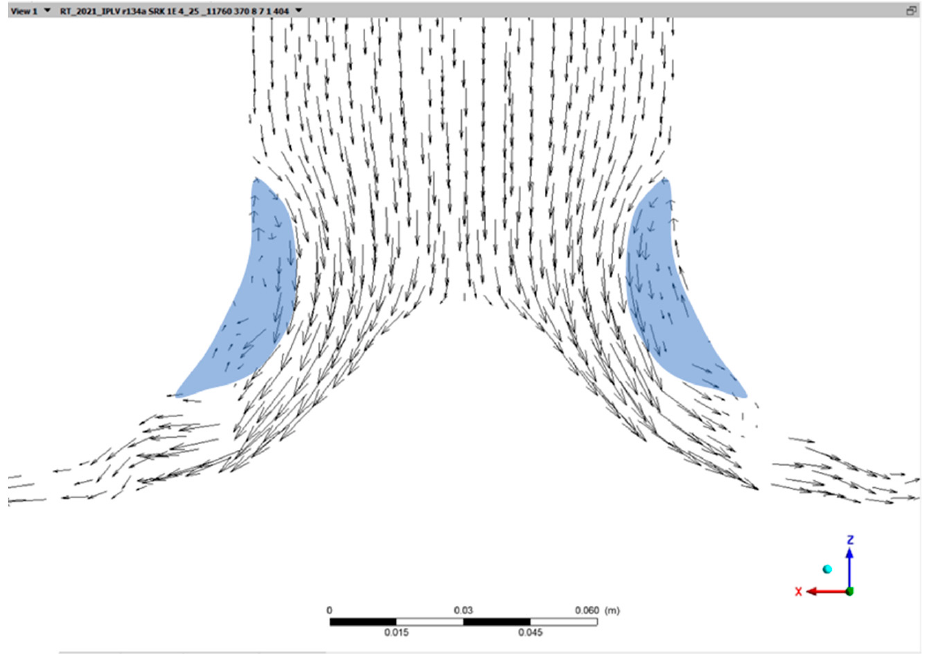
Figure 21. Compressor meridional velocity vector diagram of R-513A refrigerants under 25% load.